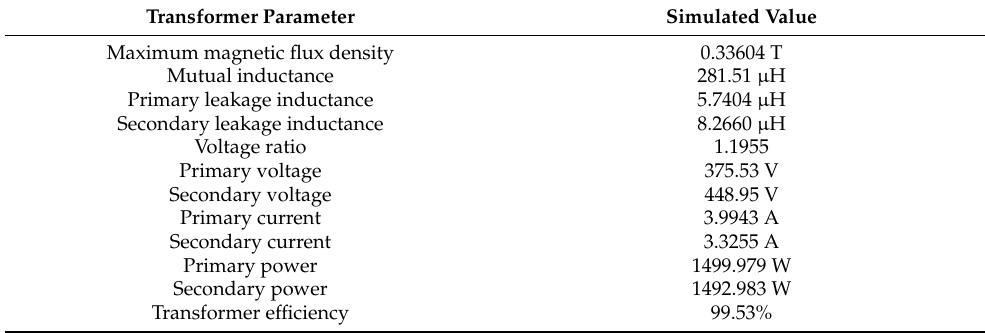
Table 7. COMSOL simulation results of the prototype HF transformer at the full-load condition and 100